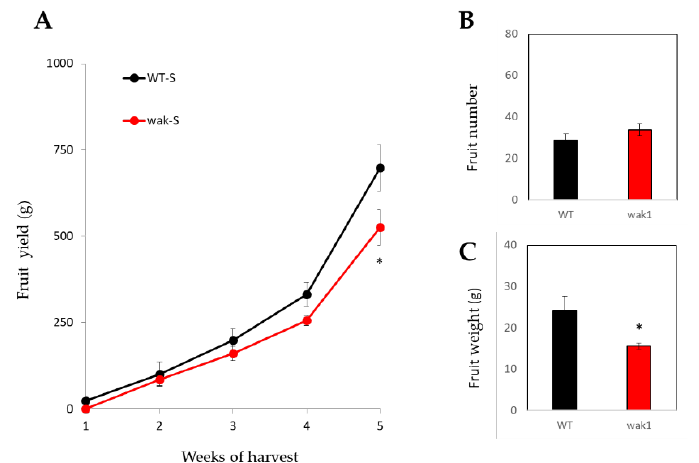
Figure 8. The null Slwak1 mutant shows salt sensitivity to long term ( A ) WT and Slwak1 mutant plants were subjected to salt stress (100 mM NaCl), and red fruits were collected for 5 weeks, determining fruit number ( B ) and ( C ) fruit weight. Values are expressed as mean ± SE ( n = 8). Asterisks indicate significant differences between mean values of WT and Slwak1 (Student’s t -test, p < 0.05).